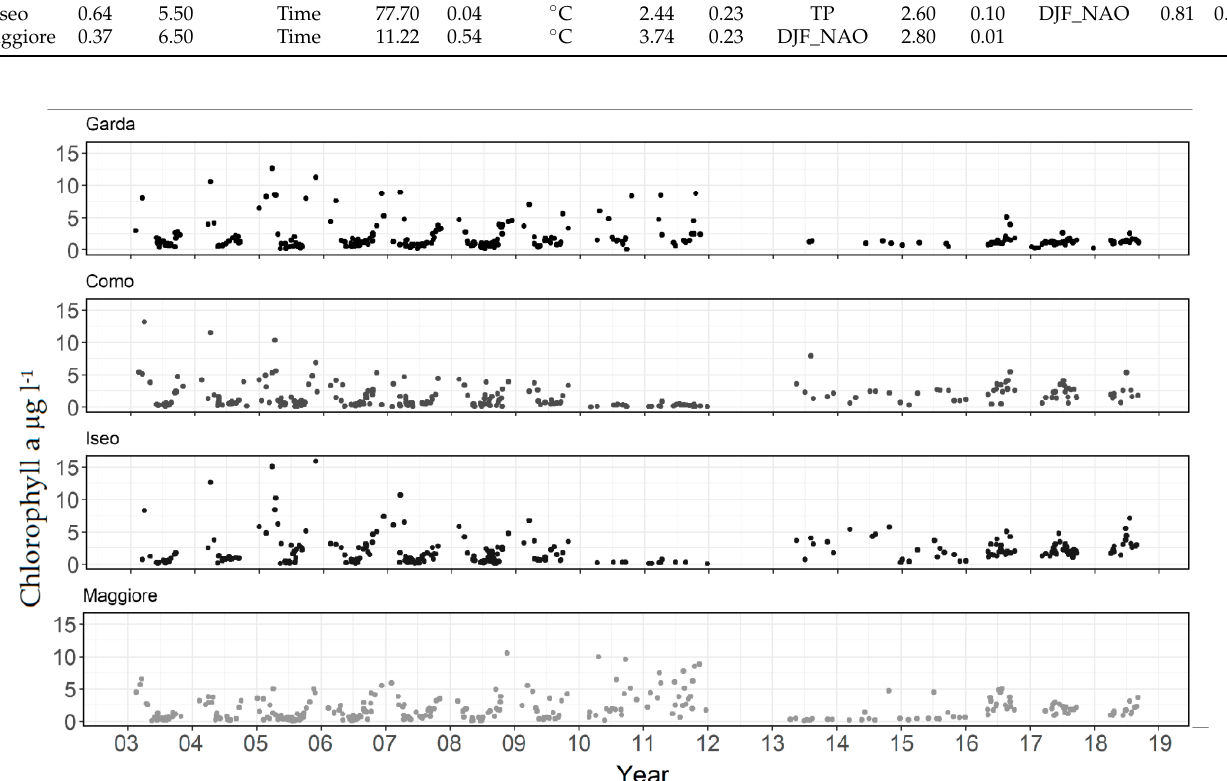
Figure 2. Chlorophyll-a derived from satellite in four subalpine lakes from 2003–2018. Contour plots were produced to visualize model results for chlorophyll-a with tem- perature over time (Figure 3). The contour lines and color intensity represent chlorophyll-a in 1 µ g L − 1 increments. Common to all the lakes were the higher concentrations in the bottom left of the figures occurring at lower temperatures (<10 ◦ C) typically found over the winter-spring during the period 2003–2010. Directly above this, in the upper left, were